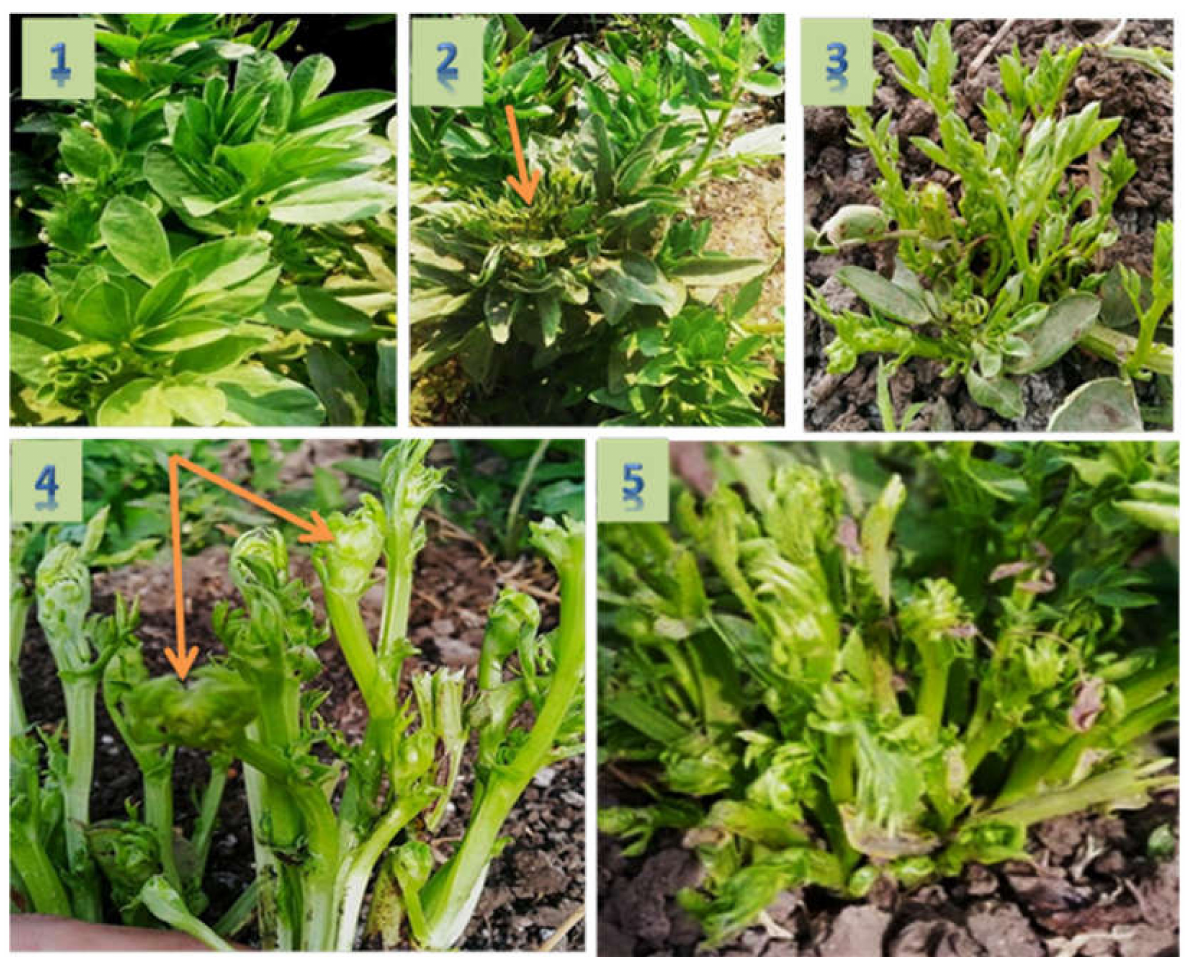
Figure 2. Disease severity index (DSI): index from 1 to 5, where 1 = no symptoms; 2 = yellow and little leaves; 3 = little leaves and stunting; 4 = shoot proliferation, yellowing, dwarfing; 5 = severe stunting and witches’